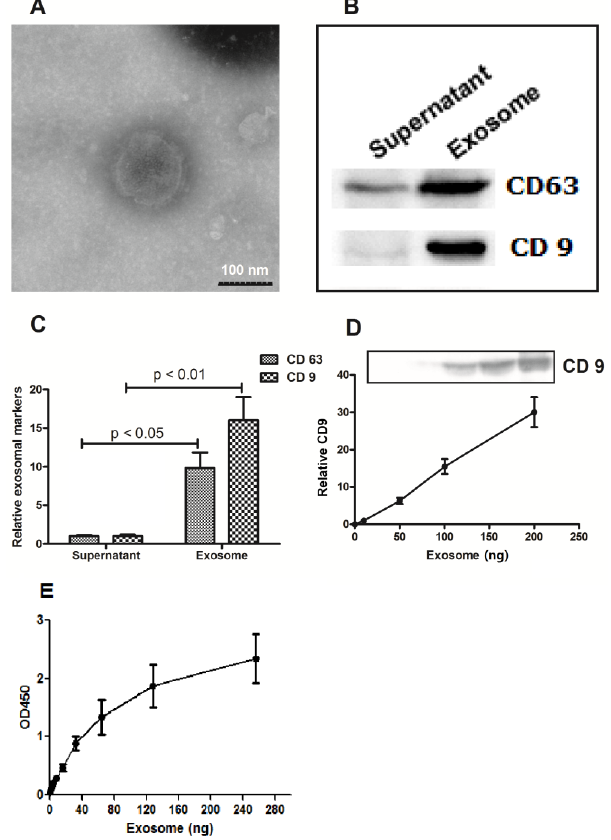
Figure 1. Confirmation of the exosomal vesicles in the cervicovaginal lavage specimens. ( A ) Electron microscopy of the vesicles from cervicovaginal lavage specimens revealed the